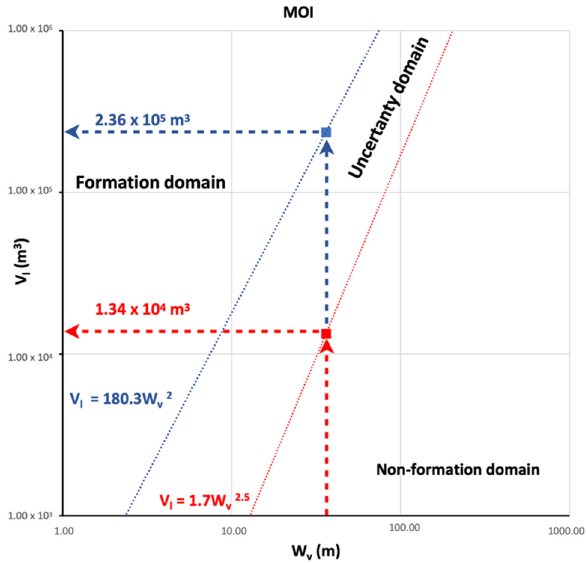
Figure 6. MOI parameter graph, the red and blue points correspond to the critical landslide volumes (V l ) for the two domains. ( V l ) for the two